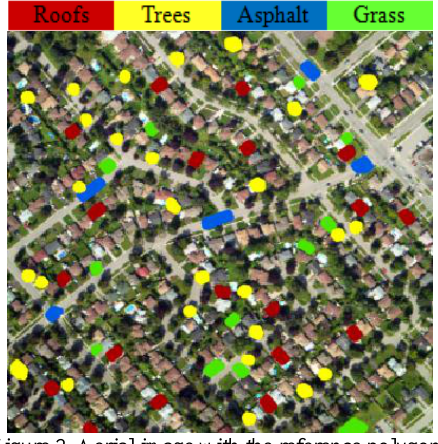
Figure 2. Aerial image with the reference polygons